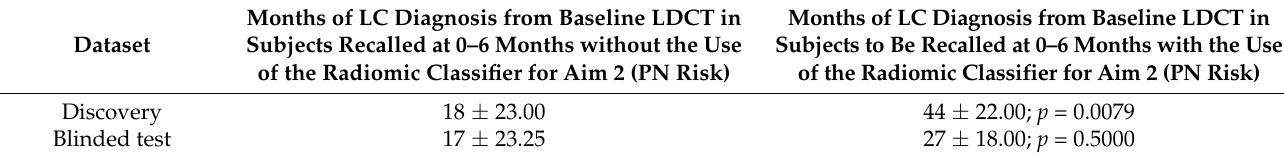
Figure 4. Percentage of LDCT second scan recalls for subjects with malignant and benign PN on the ( a ) discovery and ( b ) blinded test datasets, according to the radiomics-based classifier. Time interval for the second LDCT examination after LDCT baseline: (i) 0–6 months, (ii) 12–24 months, (iii) 24–36 months.